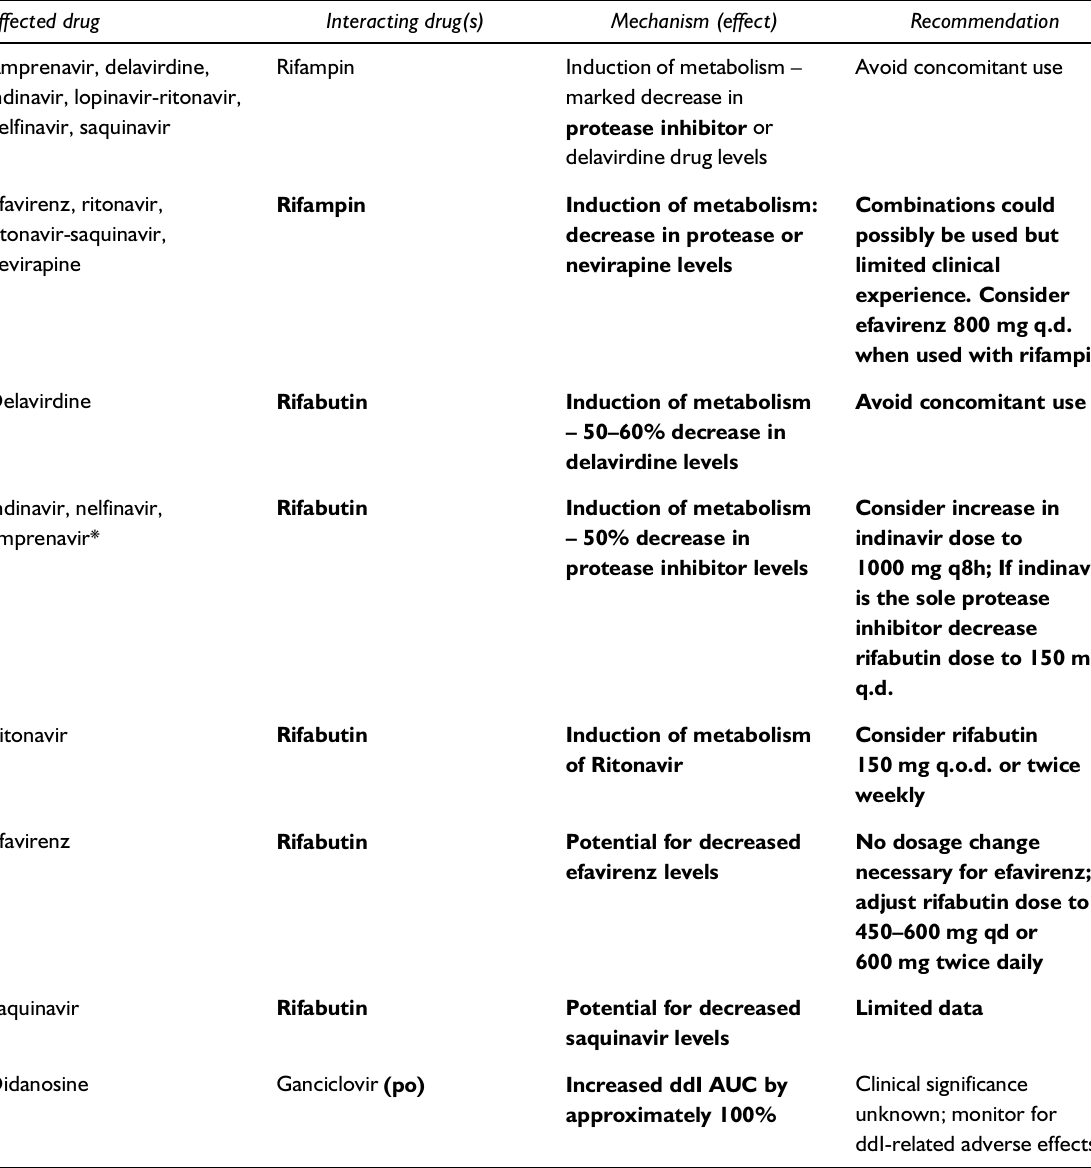
Table 6 Effects of opportunistic infection medications on antiinfective drugs commonly administered to persons infected with human immunodeficiency